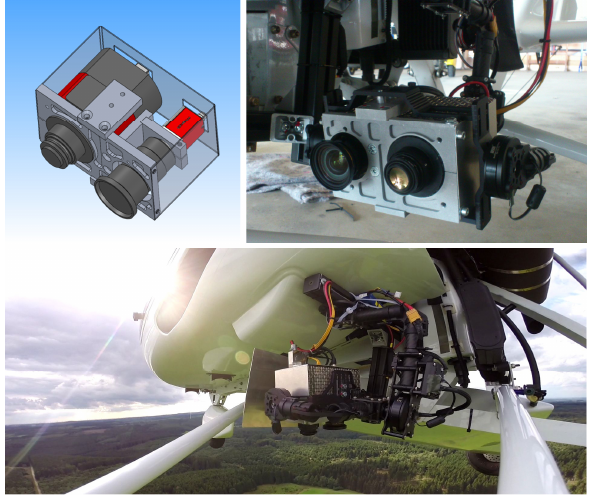
Figure 1. Top left: CAD drawing of the PanTIR system, consisting of a panchromatic (right) and a TIR camera (left). Top right: PanTIR mounted on a stabilized gimbal attached to an aircraft. Bottom: PanTIR-system airborne pointing nadir to the